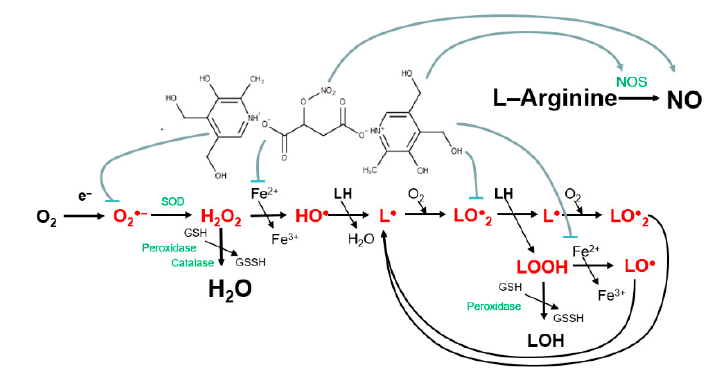
Figure 9. Scheme of the possible mechanism of action of the hybrid compound B6NO.